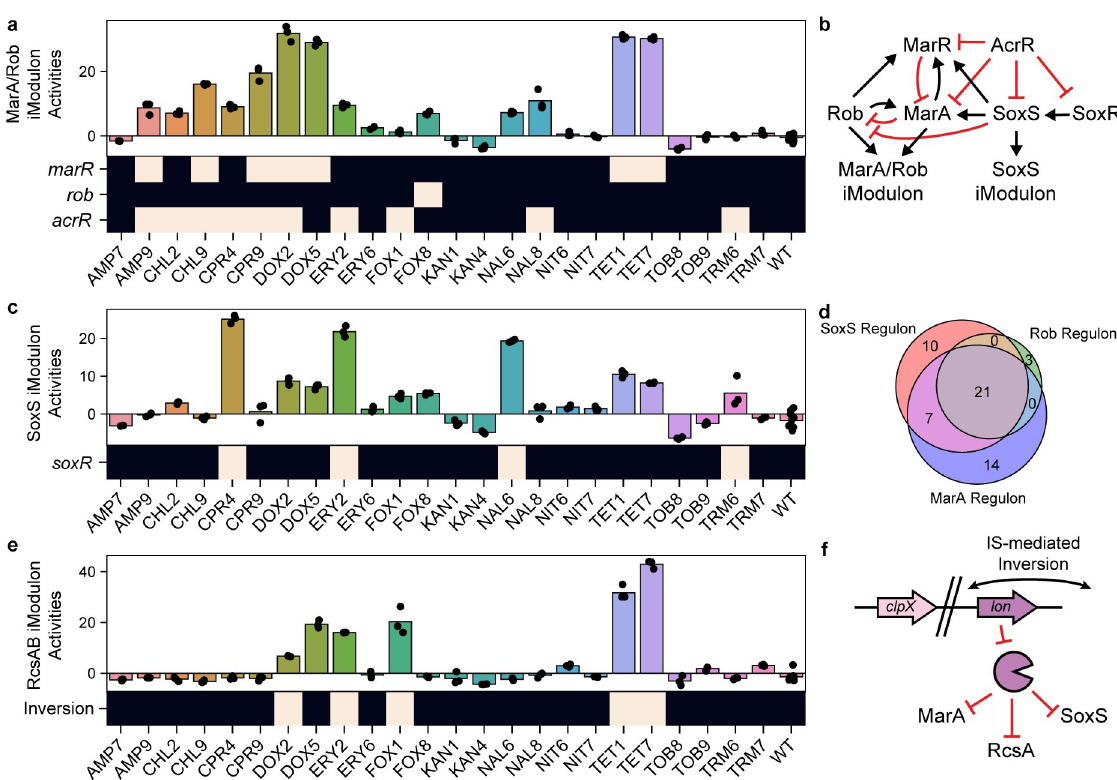
Fig 4. iModulon activities capture the effects of mutations from adaptive evolution to multiple antibiotics. (A) Bar chart of activities for the MarA/Rob iModulon. Individual points represent biological replicates. The heatmap below the bar chart shows the presence of mutations in the specified gene for the specified strain. Strain names are described in Lazar et al [34]. (B) Regulatory network for antibiotic resistance in E . coli . Black arrows indicate activation, and red arrows represent repression. Auto-regulation is not shown. (C) Bar chart of activities for the SoxS iModulon, similar to panel (A). Heatmap shows the presence of mutations in soxR . (D) Venn diagram showing the overlap of genes in the MarA/Rob iModulon and the SoxS iModulon. (E) Bar chart of activities for the RcsAB iModulon, similar to panel (A). Heatmap shows the presence of a genomic inversion. (F) Schematic illustration of the genomic inversion upstream of lon . The inversion decreases lon expression, resulting in longer residency times for MarA, SoxS, and